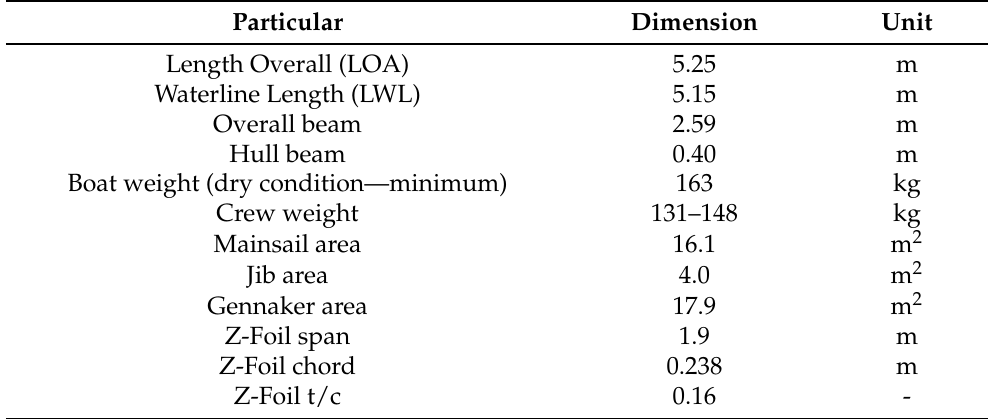
Figure 1. Longitudinal balance of forces on a NACRA 17 foiling catamaran. The main particulars of the NACRA 17 are detailed in Table 1. Table 1. NACRA 17